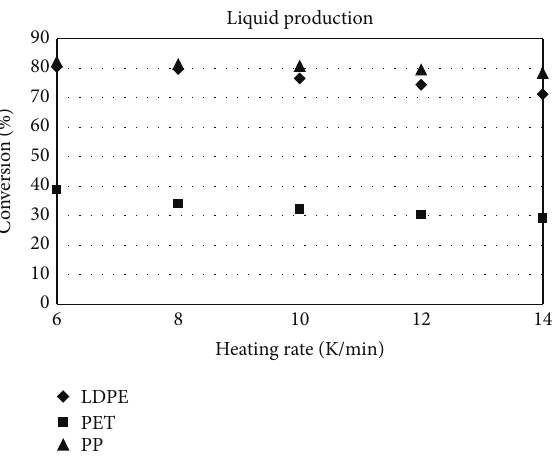
Figure2:Theeffectoftemperatureincreasingrateonliquidproduct of each plastic